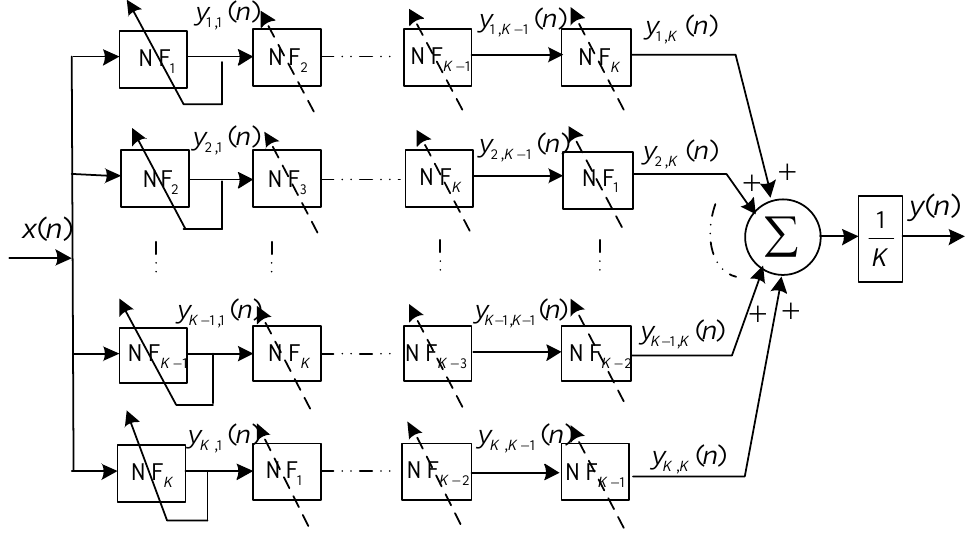
Figure 4. The framework of cyclic cascaded high order complex-coefficient matrix adaptive notch filter based on one order complex-coefficient adaptive notch filter